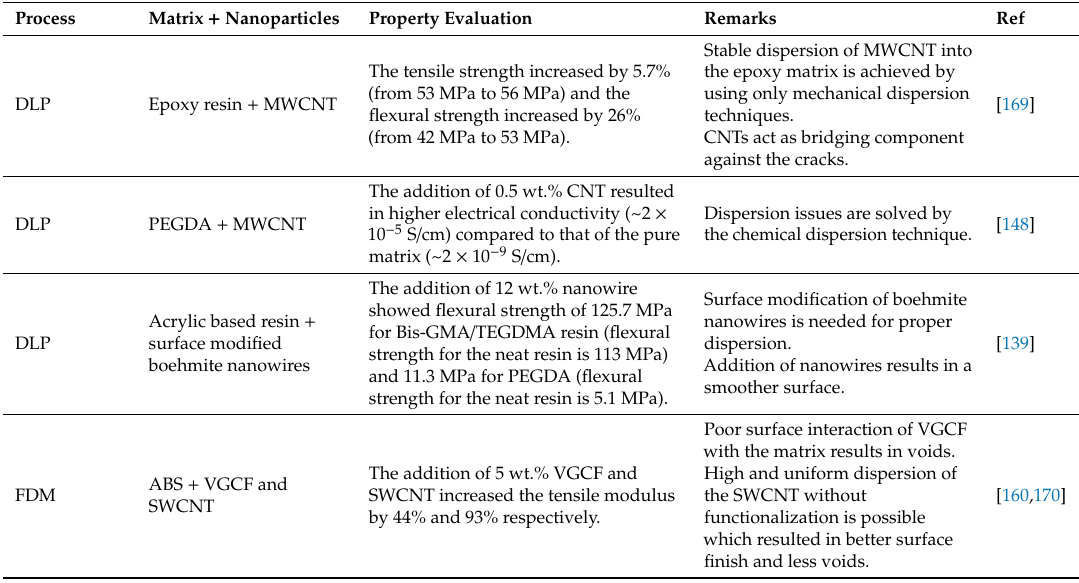
Table 3. A summary of different nanoparticle reinforcements into polymer matrix for 3D